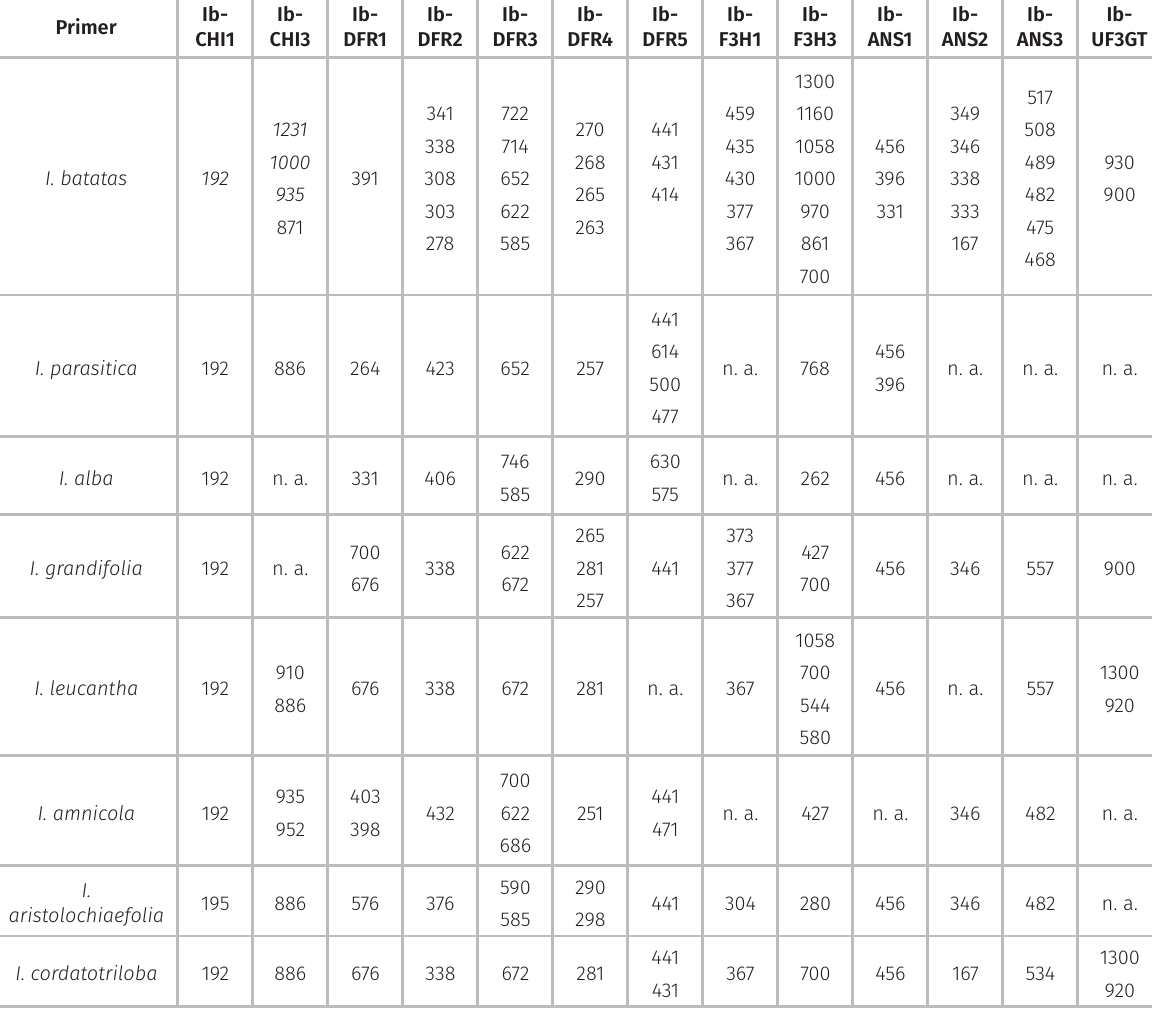
Table IV. Amplified alleles of ILP-GC markers in I. batatas and wild relatives. Sizes are indicated in base pairs (bp).